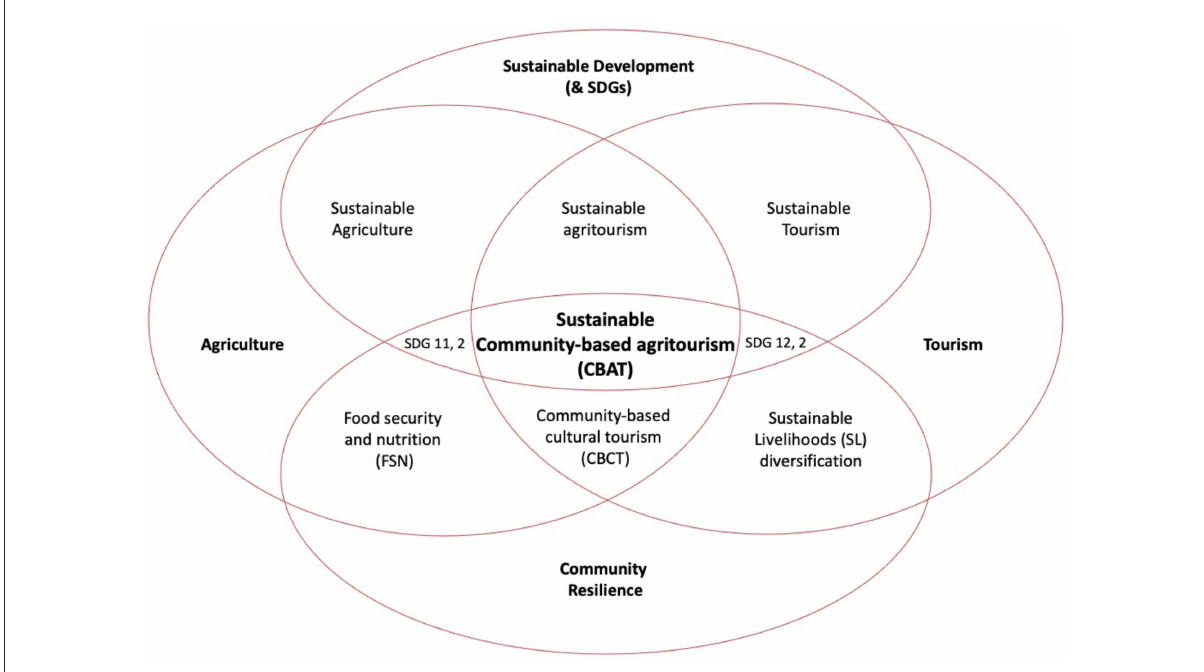
FIGURE1 Conceptual representation of community-based agritourism (source: authors).